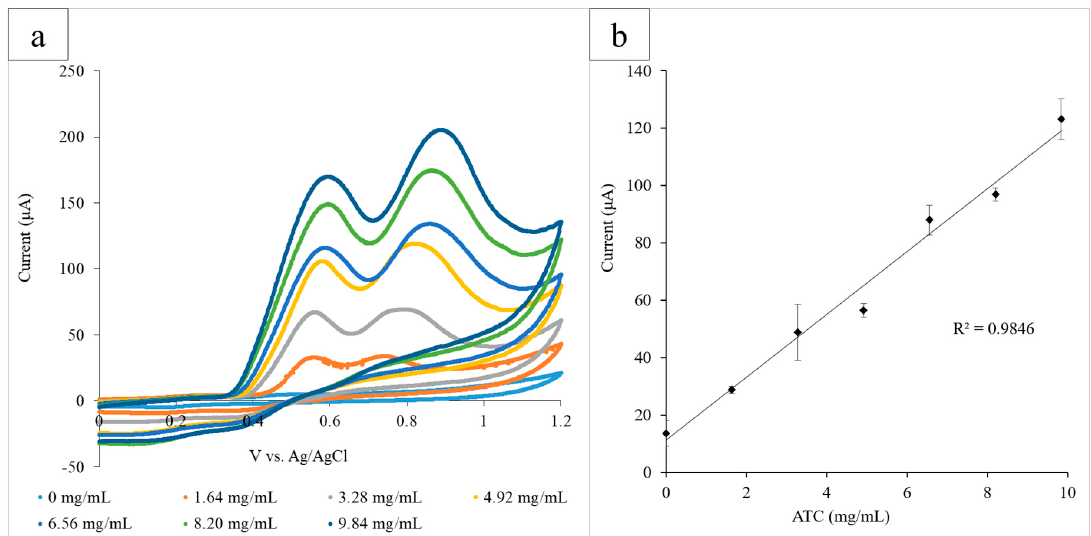
Figure 3. ( a ) Cyclic voltammograms for the increasing ATC concentrations measured using the paper platform in triplicate. The current output at the oxidation peak (0.60 V) increased proportionally with the glucose concentration; ( b ) the calibration curve measuring the current output at 0.60 V vs. ATC concentration. A linear correlation between the current and concentration was found to have an R 2 value of 0.985.